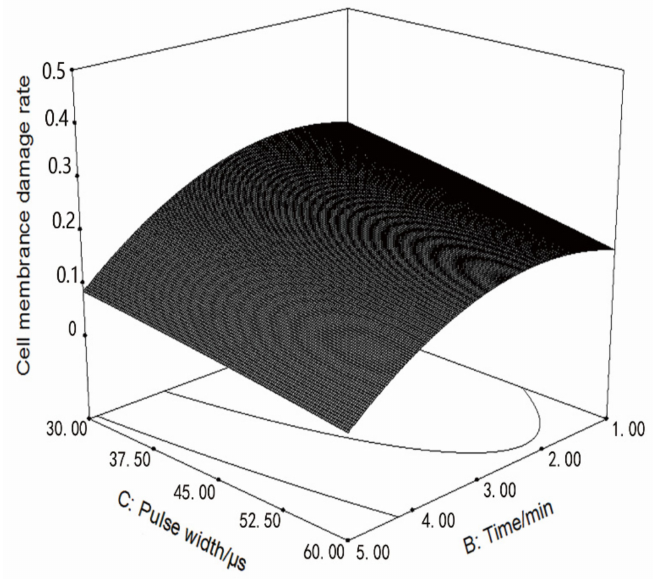
Figure 4. Response surface analysis of processing time and pulse